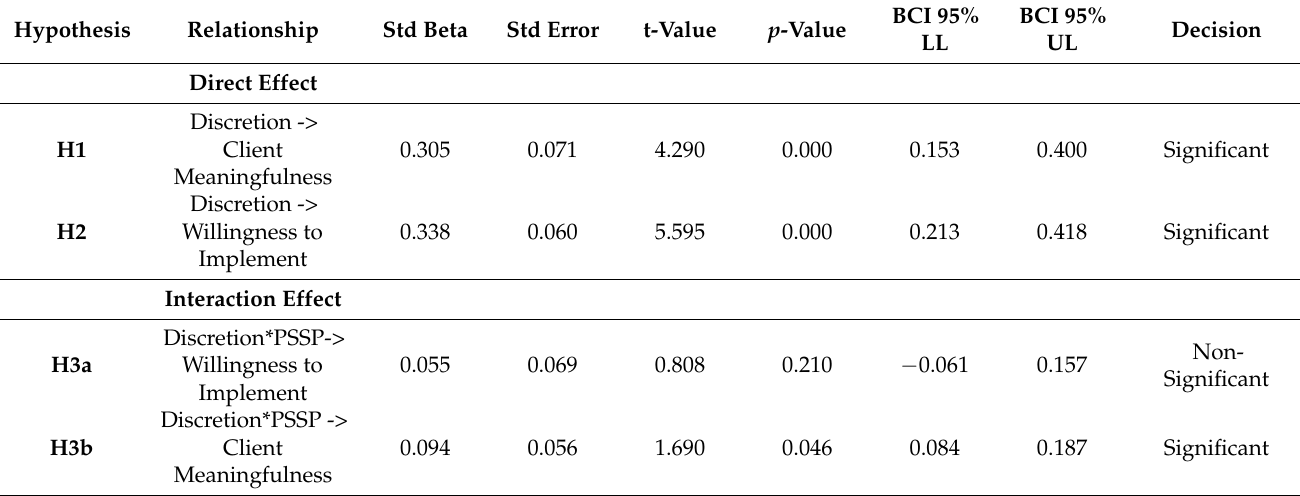
Table 3. Hypotheses testing: direct and interaction effect.